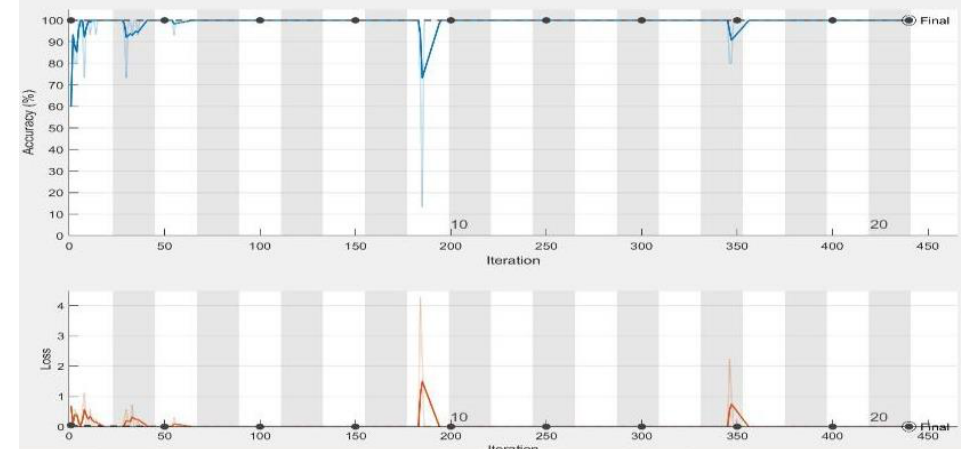
Figure 11. AlexNet training process with a learning rate of 0.0001. The figure shows the epoch number, training accuracy (blue line), validation accuracy (black line), and loss function value for the training data (red line) and validation data (black line).